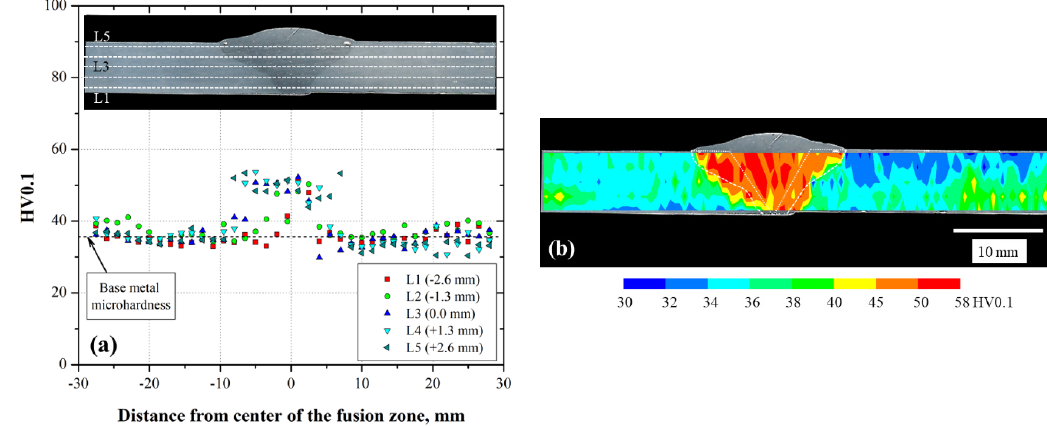
Figure 8. Microhardness evolution of the 3003-H14 welded plates: ( a ) microhardness profile and ( b ) map representation.